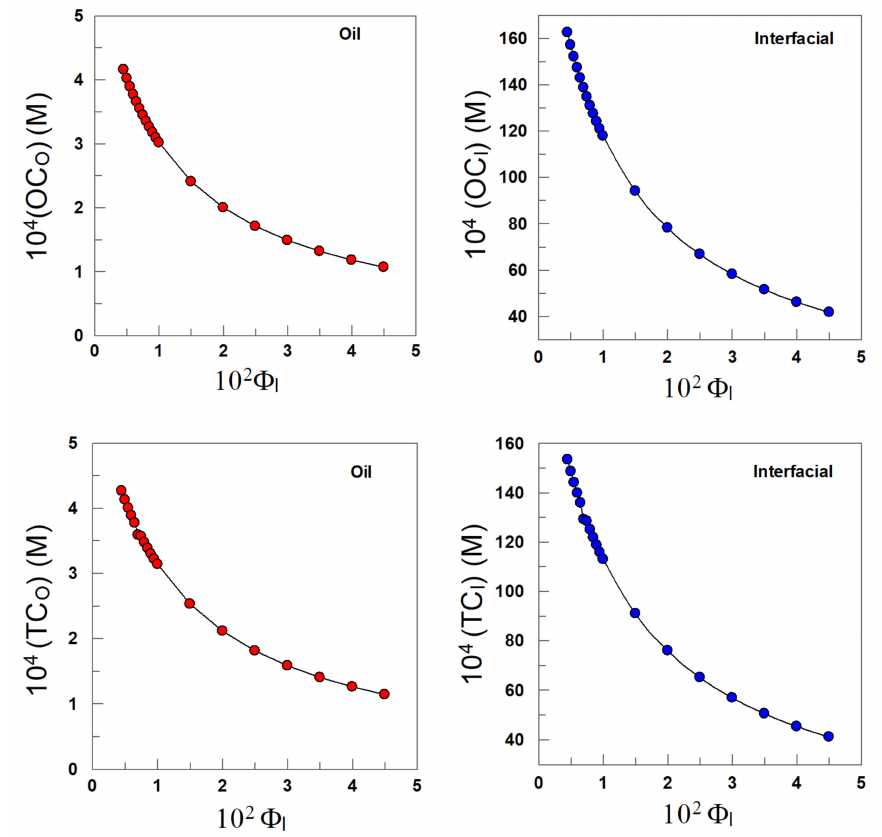
Figure 5. Variations of the effective concentrations of OC and TC in the oil and interfacial regions of corn emulsions with Φ I